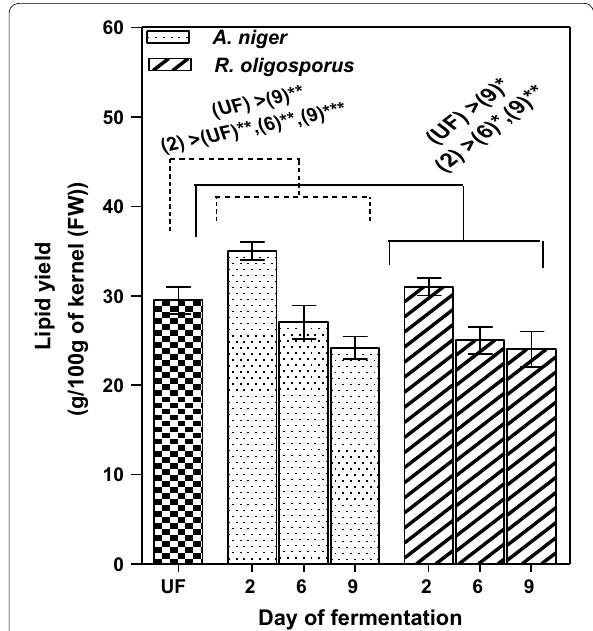
Fig. 7 The time course of oil production by Aspergillus niger and Rhizopus oligosporus strains in apricot kernels during SSF. Results are given as mean SD (n 3); *p < 0.05, **p < 0.01, ***p < 0.001 ± = (repeated measures ANOVA “Tukey’s Multiple Comparison Test”).